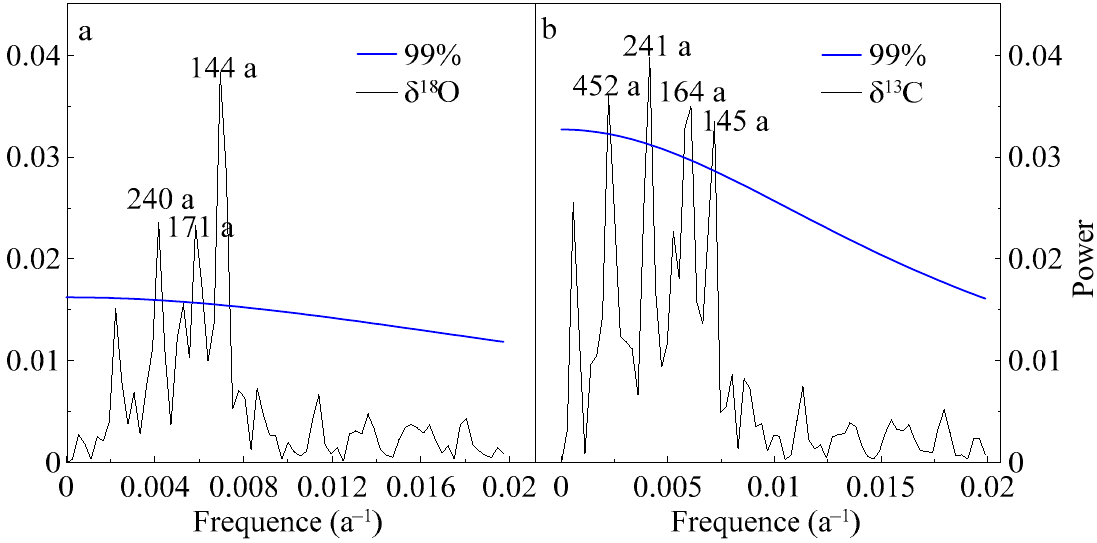
Figure 5. REDFIT spectral analysis of SYG1 δ 18 O ( a ) and δ 13 C ( b ) by using the software program Past3 [35]. The solid blue line represent 99% confidence level.